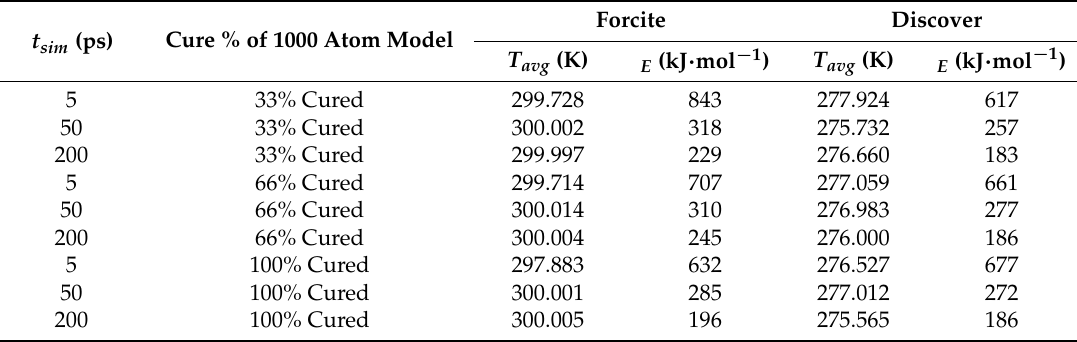
Table 1. Average temperature and standard deviation of total energy retrieved from the reactive molecular dynamics (RMD) simulations of each of the models using the Nos é –Hoover thermostat in the Discover module.